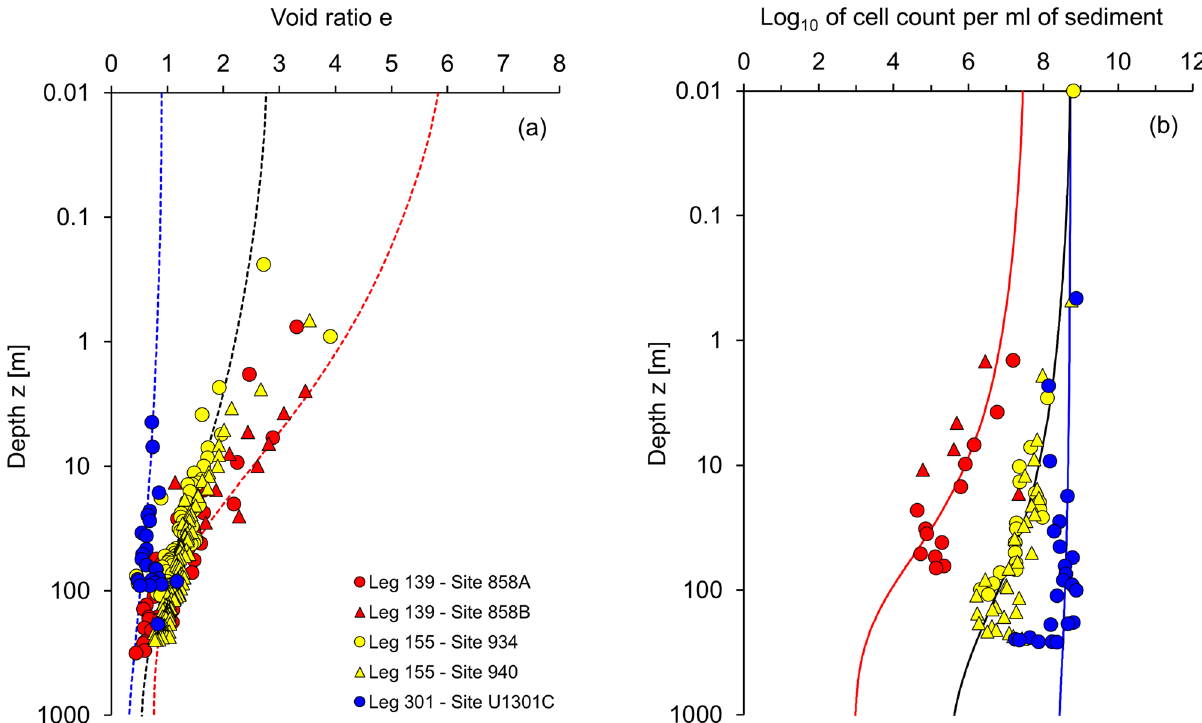
Figure 2. Cell count and void ratio profiles—Data and prediction models. ( a ) Void ratio depth profile. ( b ) Cell count profile. Data from Leg 139—Site 858A/B at Juan de Fuca Ridge (model parameters: e L = 6.0, the estimated cell concentration of the pore fluid c fl = 10 10.2 cell counts/cm 3 ), Leg 155—Site 934/940 at Amazon Fan (model parameters: e L = 2.8, the estimated cell concentration of the pore fluid c fl = 10 9.5 cell counts/cm 3 ), and Leg 301 Site U1301C at Juan de Fuca Ridge (model parameters: e L = 0.9, the estimated cell concentration of the pore fluid c fl = 10 9 cell counts/cm 3 ). See Supplementary Table S3 and Figs. S8–S121 for the complete